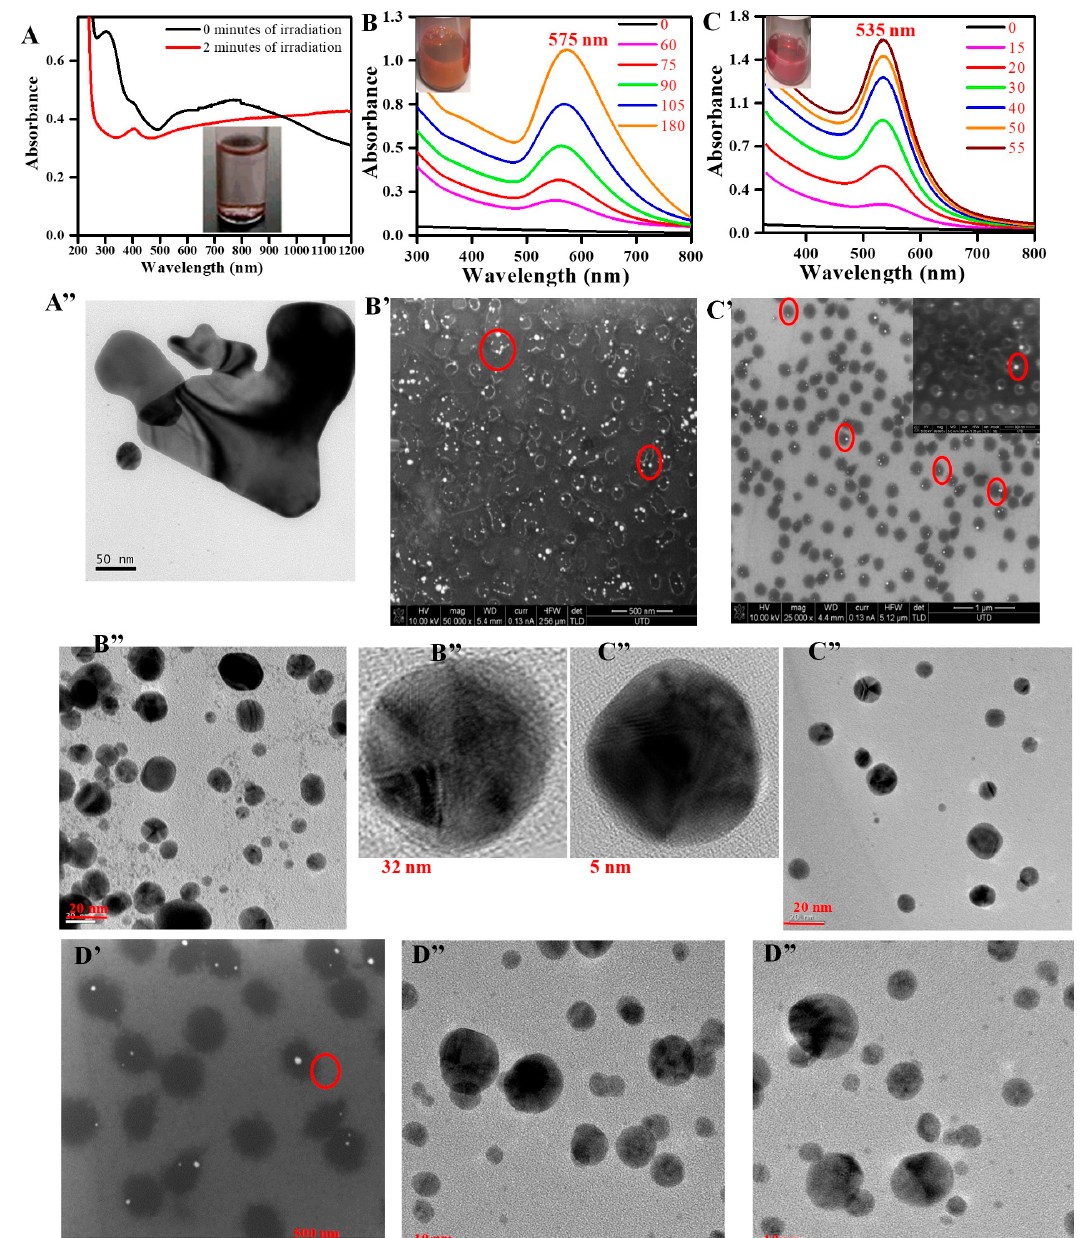
Figure 1. Absorption spectra and electron microscopy images of spherical gold nanoparticles (AuNPs) formed using chloro(dimethyl sulfide)gold (I) (Au(Me 2 S)Cl) precursor under different irradiation conditions within deionized (DI) water and poly( N -isopropylacrylamide) (PNIPAm) microgels. Traces ( A and A’’ ) illustrate absorption spectra and TEM images of decomposed Au(I) in DI water. Traces ( B , B’ , and B’’ ) depict absorption changes vs. time (minutes), SEM and TEM images for AuNPs formed under ambient light within PNIPAm- co -allylamine microgels. Traces ( C , C’ , and C’’ ) represent absorption changes vs. time (minutes), SEM, and TEM images for AuNPs formed by photoirradiation within PNIPAm- co -allylamine microgels. Traces ( D’ and D’’ ) show SEM and TEM images of AuNPs formed by photoirradiation within PNIPAm- co -acrylic acid microgels. Refer to Figure S3 for the corresponding absorption spectra of sample D’ and D’’.